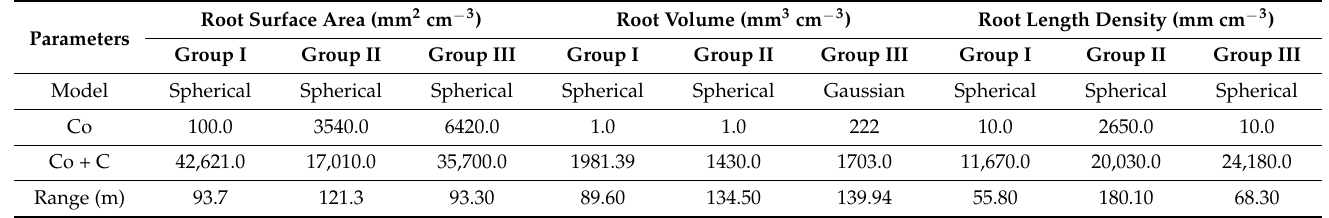
Table 3. Estimated models and parameters of experimental semivariograms for the variables studied of the groups of six C. canephora genotypes in Nova Ven é cia—Esp í rito Santo,